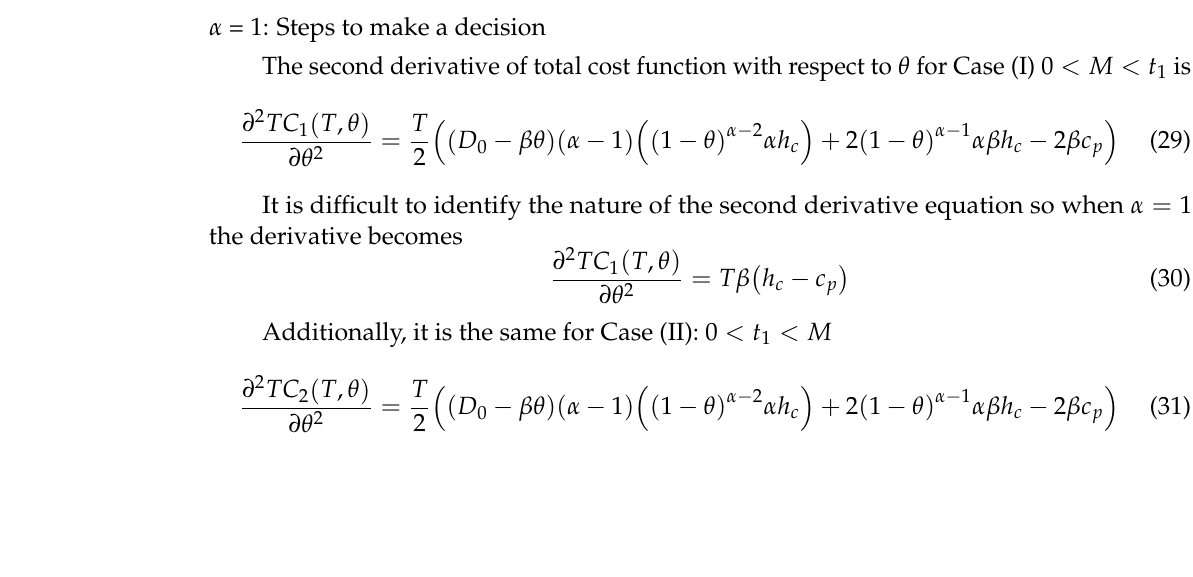
Figure 5. Optimal range of